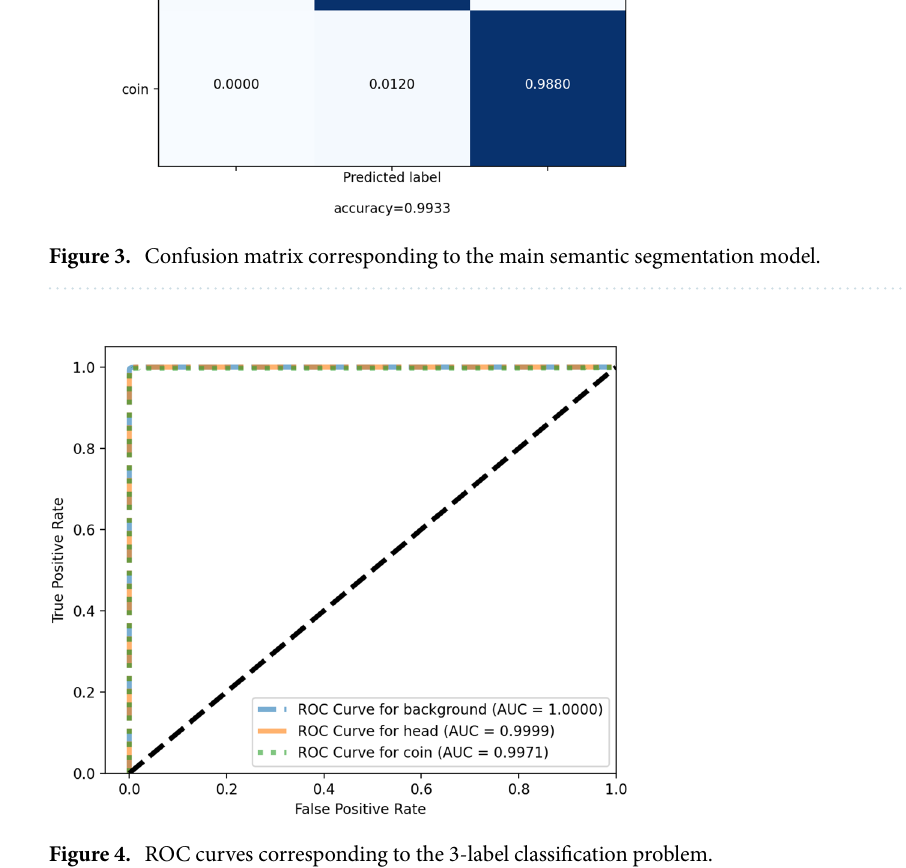
Figure 4. ROC curves corresponding to the 3-label classification